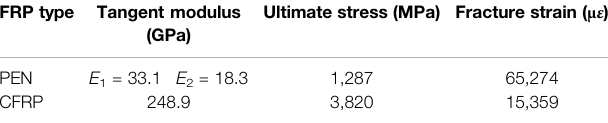
TABLE 3 | Mechanical properties of FRPs.